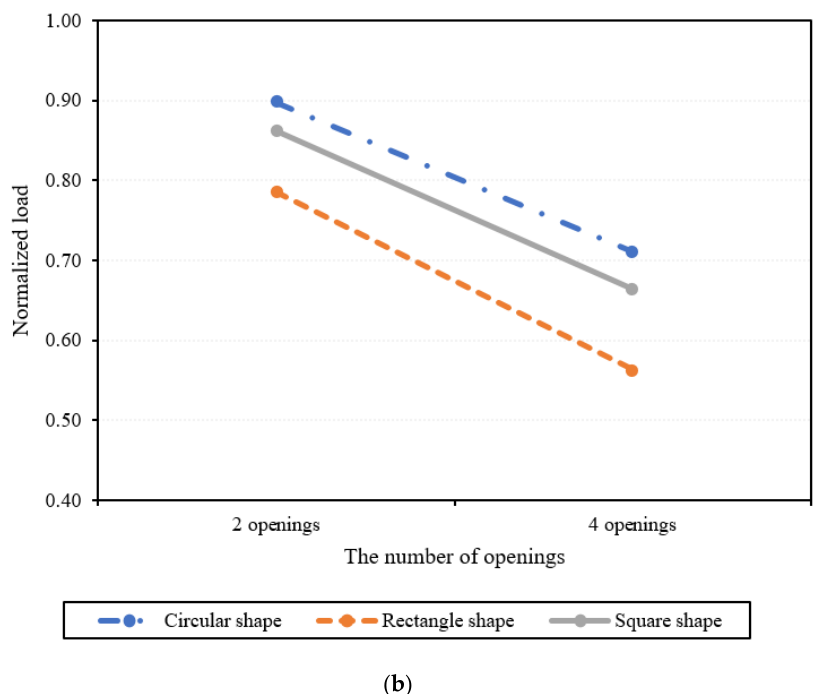
Figure 16. Punching shear capacity of the different the number of openings ( a ) Openings at 4H ( b ) Openings at 1H.